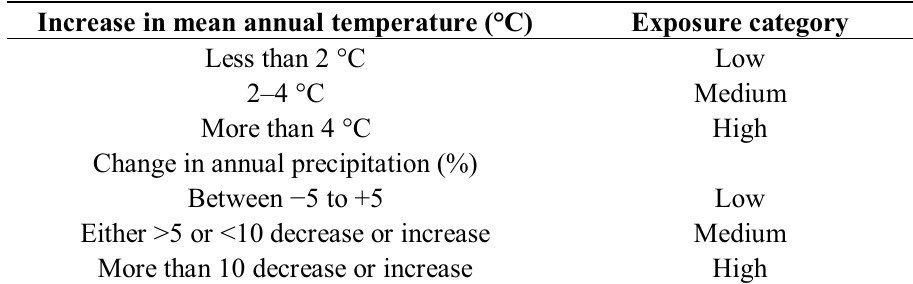
Table 3. Climate change exposure categories.